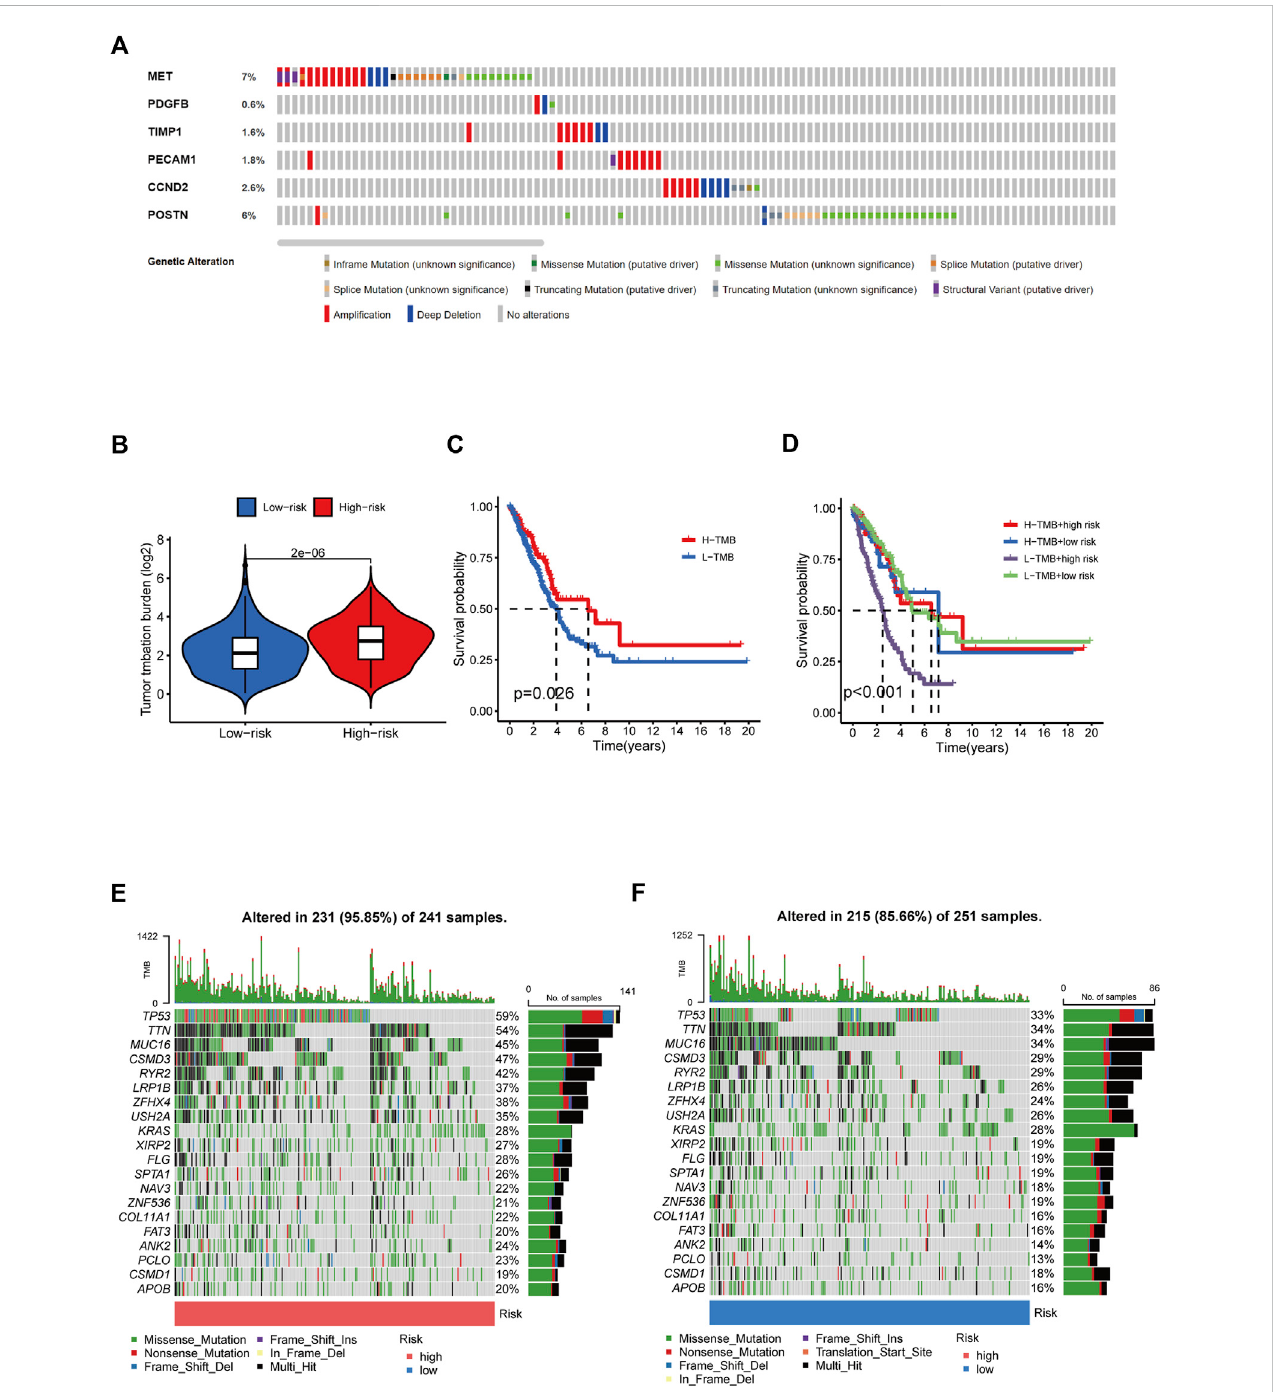
FIGURE 8 Tumormutationburdenandgenemutationanalysis. (A) GeneticalterationanalysisoftheARGsintheTCGALUADcohort. (B) TMBbetweenthelow-and high-risk subgroups based on RS. (C) Survival study of thevarious TMB strati fi cation groups. (D) Analysisof thesurvival ofvariousgroups strati fi ed byTMB and RS. (E, F) Assessment of the differences in the mutational landscape between high- and